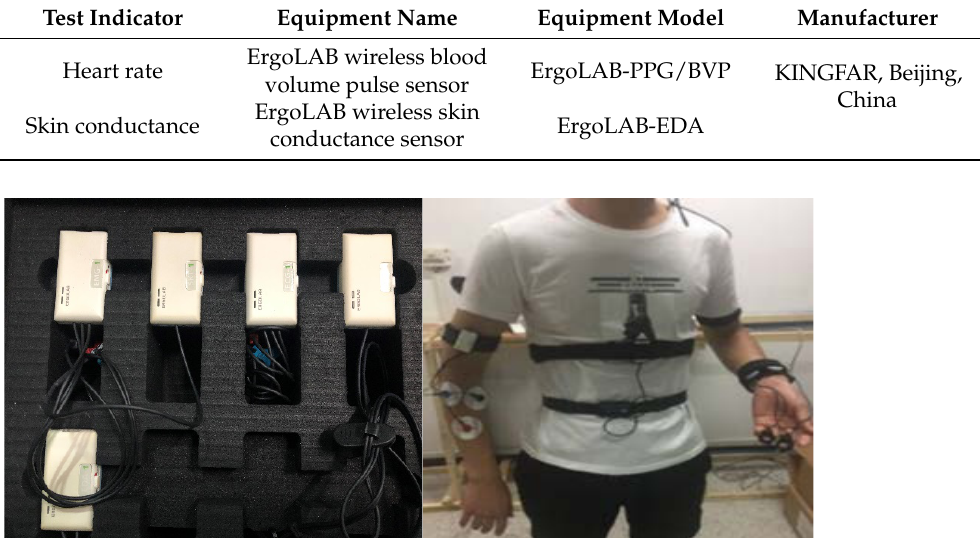
Table 2. Test indicators and equipment.